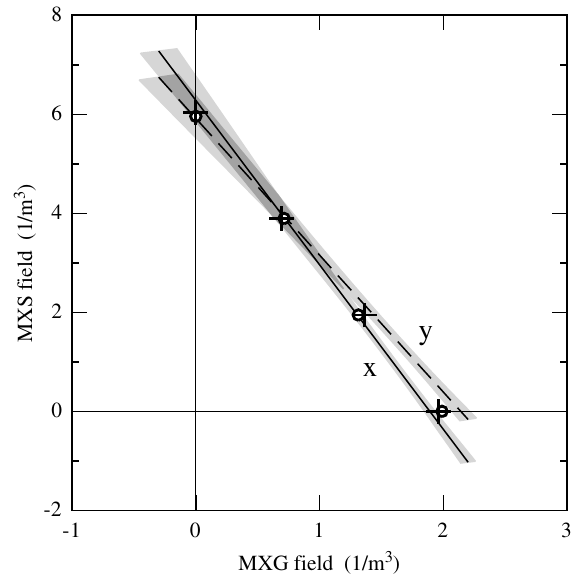
FIG. 3. (from Ref. [1]) This figure represents the MXS ×MXG ¼ − 0 . 14 m − 3 . The gray bands represent the plane where B MXL error about the lines of zero x and y chromaticity. Scans of the MXS and MXG sextupole family currents found several local points of maximal IPP lifetime. The circles represent a beam setup with horizontal heating; the plus signs represent runs with enhanced longitudinal width. The error bars are smaller than the